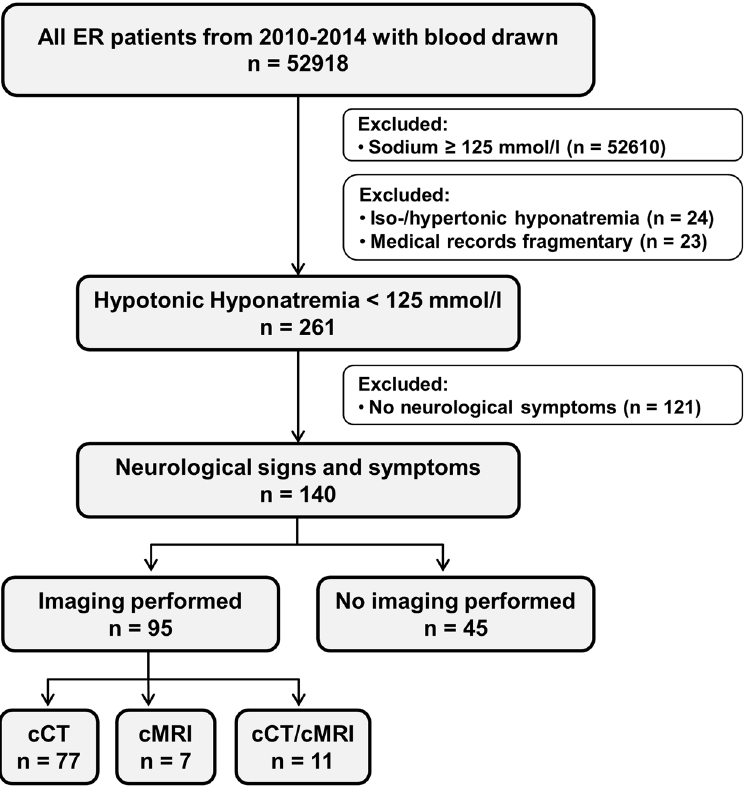
Figure 1. Participant flow chart of emergency admissions with profound symptomatic hyponatremia (University Hospital Münster, 2010–2014). ER, emergency room; cCT, cranial computed tomography; cMRI, cranial magnetic resonance